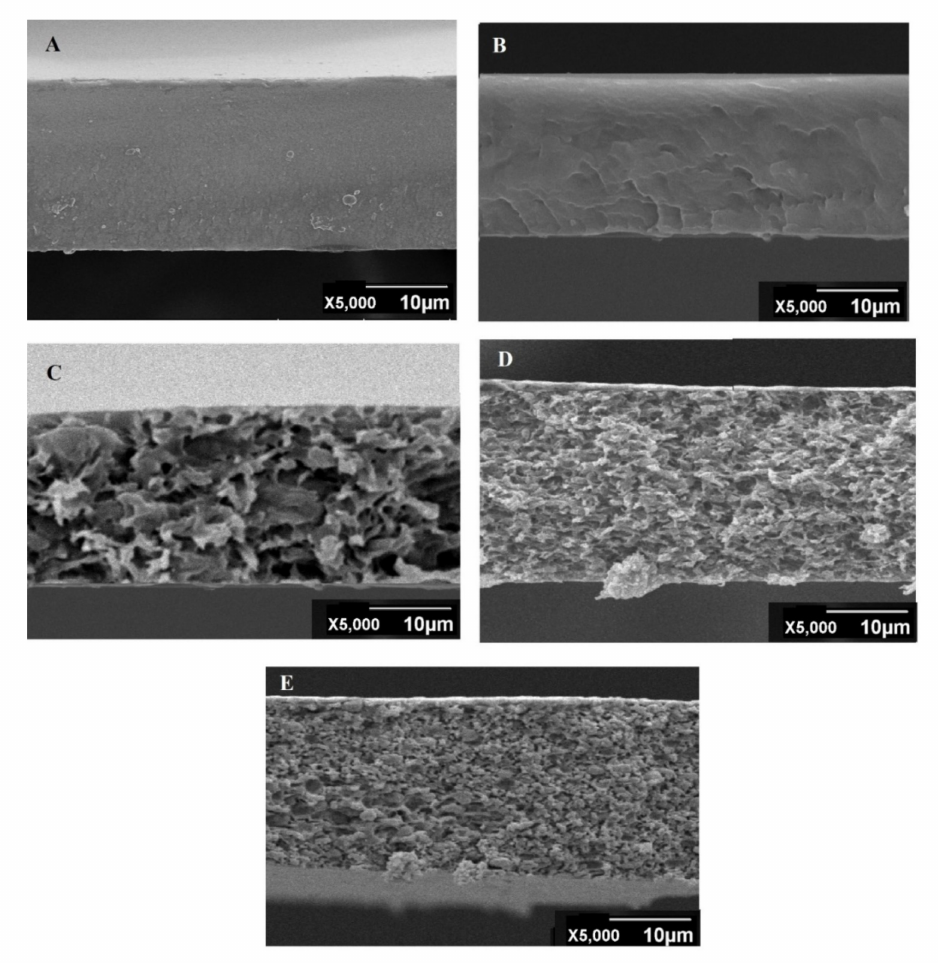
Figure 5. Cross-section SEM images of ( A ) CTA:CDA (100:0), ( B ) CTA:CDA (0:100), ( C ) CTA:CDA (80:20), ( D ) CTA:CDA (60:40) and ( E ) CTA:CDA